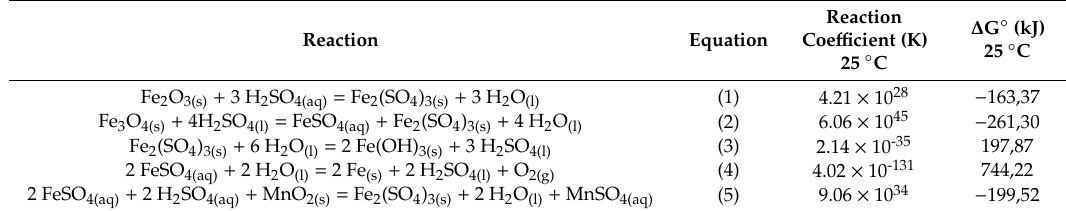
Table 1. Thermodynamic information of the reactions (based on HSC Chemistry